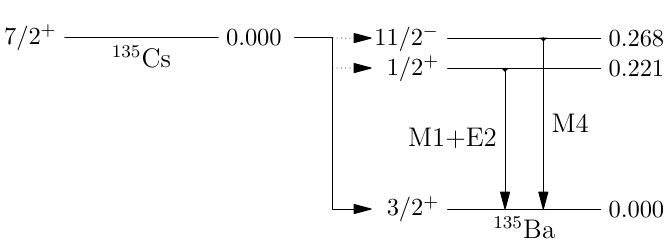
Figure 2. β − -decay transitions from the ground state of 135 Cs to the ground state and first two excited states in 135 Ba. The numbers to the right of the energy levels are excitation energies in MeV.